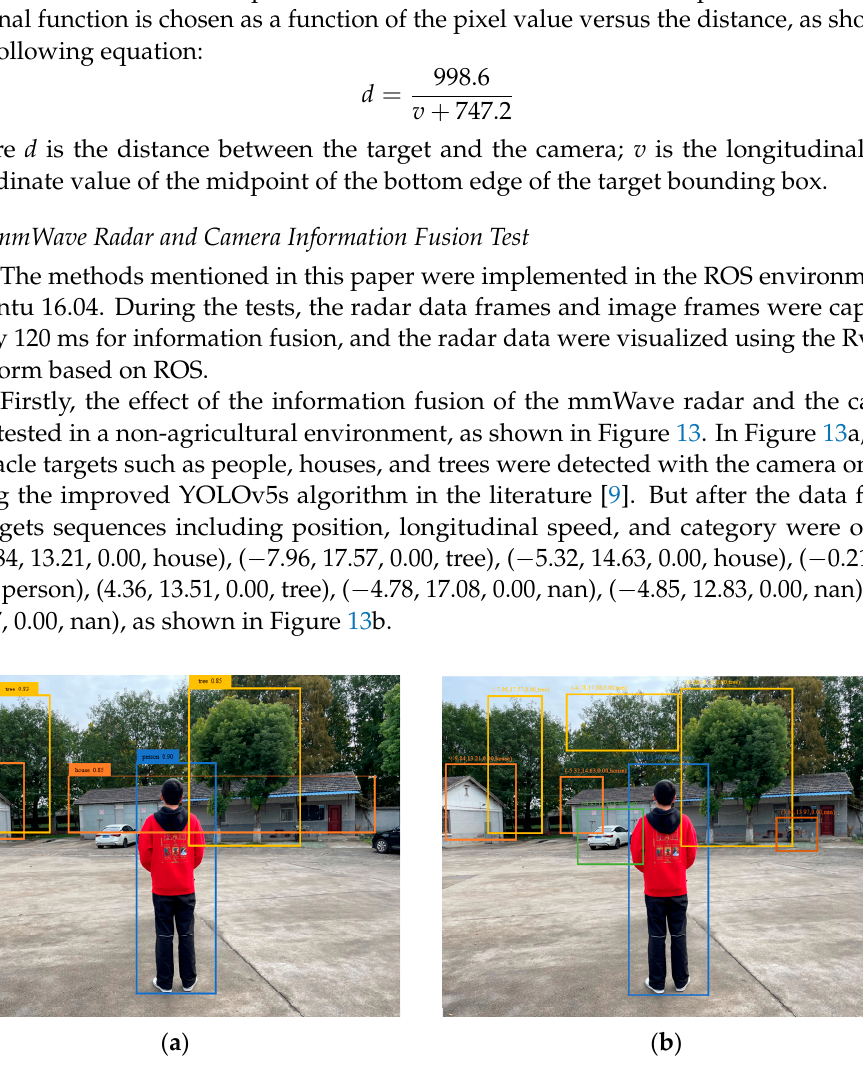
Figure 13. Information fusion detection test of mmWave radar and camera in non-agricultural en- vironment. ( a ) Detect with camera only. ( b ) Fusion detection of camera and mmWave radar.